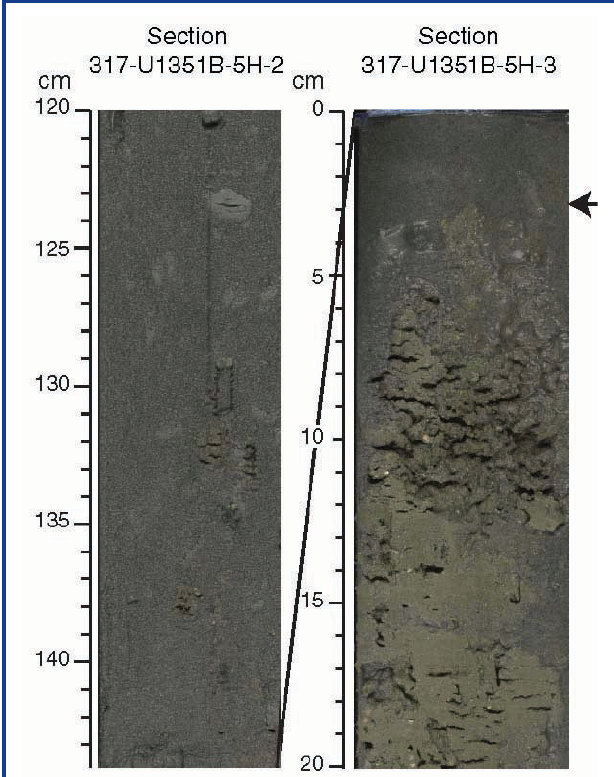
Figure 8. Core photographs of a lithologic surface and associated sediments in Unit I at outermost shelf Site U1351. Gray sand overlies greenish mud at a burrowed contact (arrow). This contact correlates with the predicted depth of seismic sequence boundary U18 (from Fulthorpe et al.,